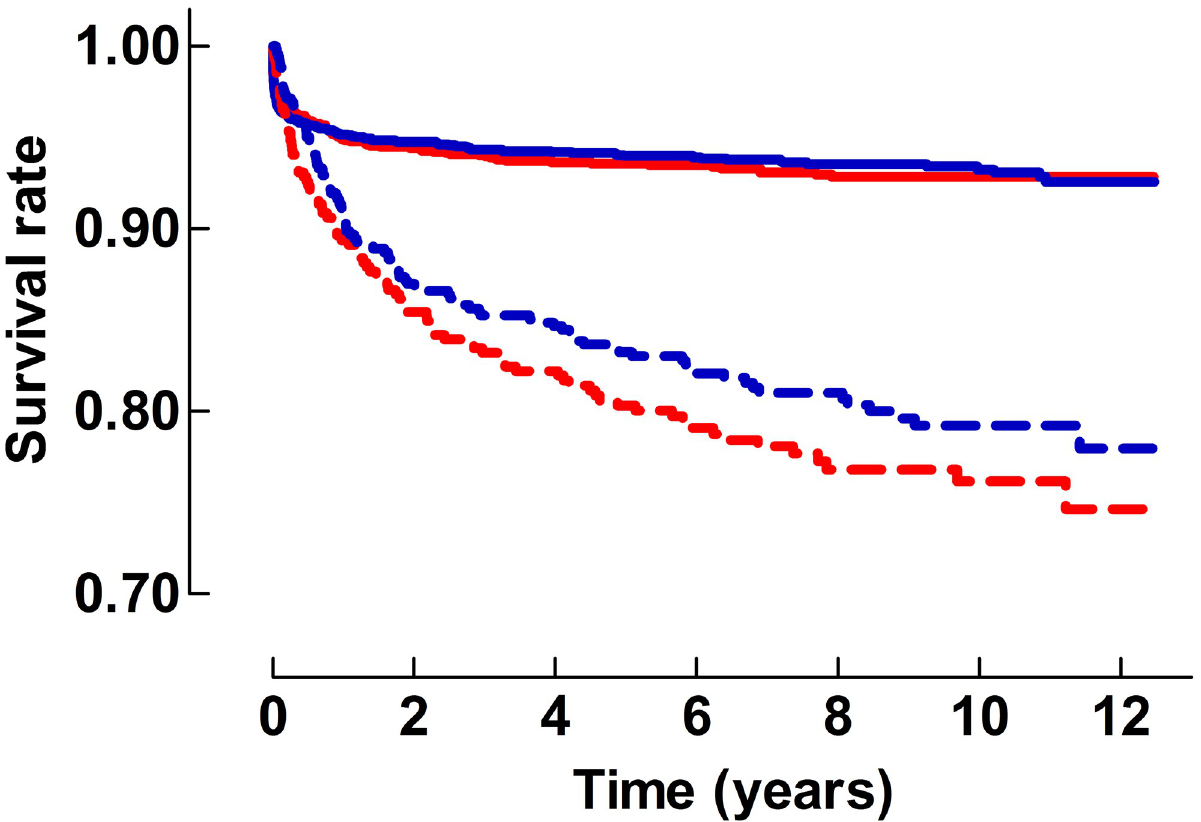
Fig 2. Survival rates from the first admission to the PICU. The figure shows a comparison of the survival rate with time from the first admission to the PICU after single and repeated admissions respectively. Solid lines = Data from patients with a single admission. Dotted lines: Data from patients with repeated admissions. Blue lines: Data from boys. Red lines: Data from